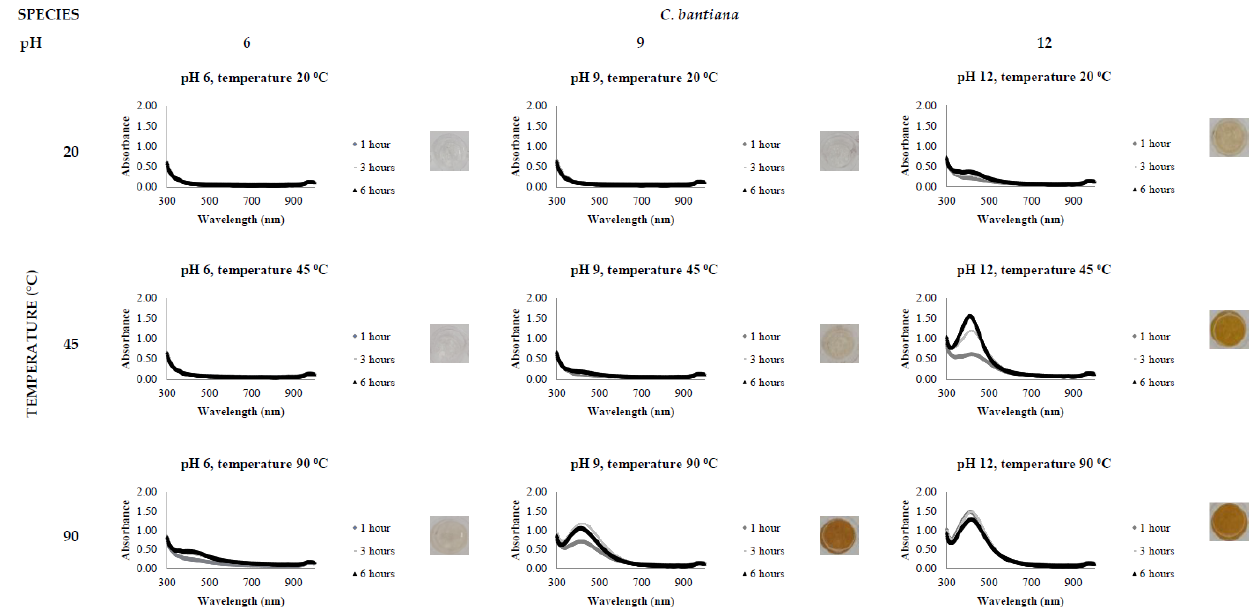
Figure 2. LSPR spectra of C. bantiana cell-free extract in the synthesis of AgNPs, by the addition of 0.5 mM AgNO 3 , varying the reaction time (1, 3 and 6 h), temperature (20, 45 and 90 °C) and pH (6, 9 and 12), through UV-Vis spectrophotometry analysis.